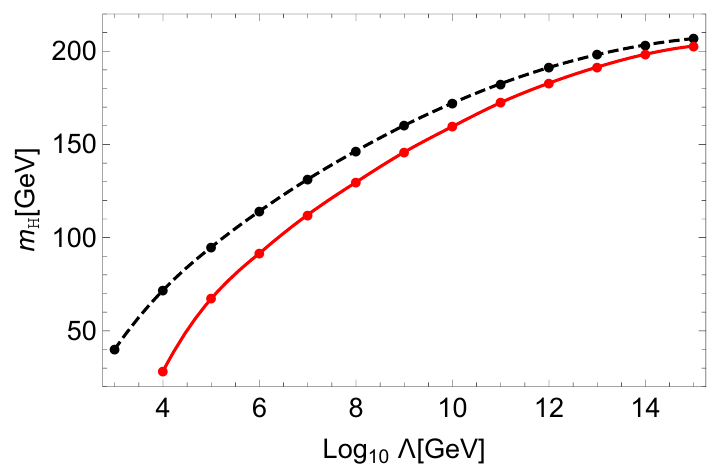
Figure 2 . Lower Higgs-mass bounds with a single minimum in the e(cid:11)ective Higgs potential. The black-dotted line depicts the conventional lower mass bound for the considered toy model without dark matter or the in(cid:13)uence of any higher-dimensional operator in the UV. The red solid line demonstrates how fermionic dark matter as well as other higher-dimensional operators can diminish this bound without introducing a metastability in the e(cid:11)ective potential. Thus the cuto(cid:11) scale of new physics (cid:3) is